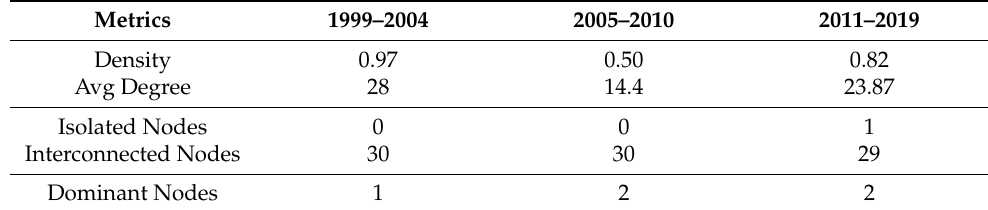
Table 3. Network metrics for 0.8 threshold level on the GDP (constant 2010 US$) variable.